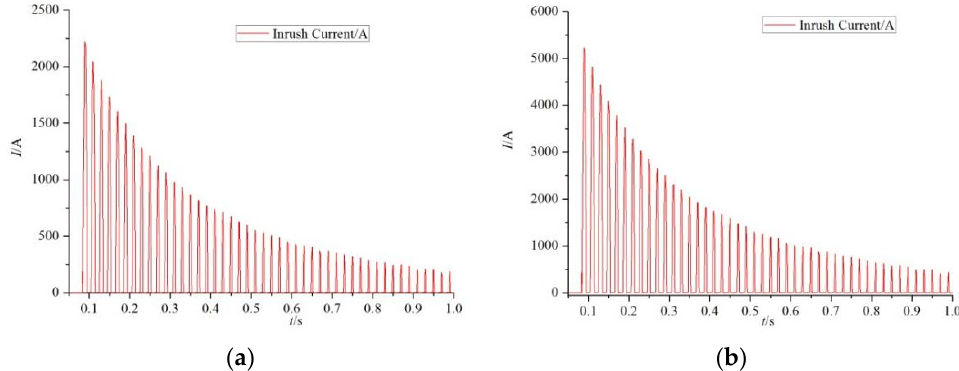
Figure 10. Waveform of inrush current under different residual flux when switching angle θ = 0°: ( a ) B r = 0.68 T; ( b ) B r = 1.13 T. Figure 11 shows the corresponding inrush current amplitude under different residual fluxes and closing angles.